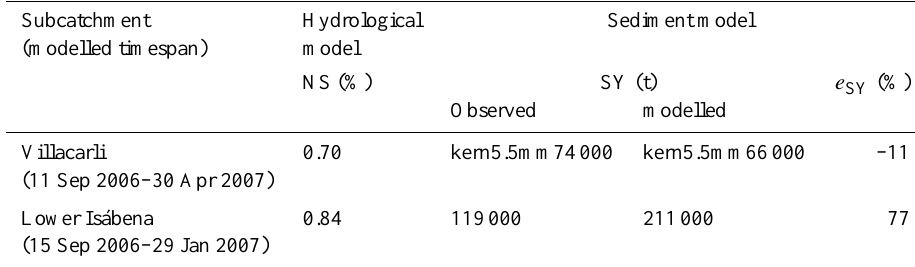
Table 6. Summary of model performance of the Is´abena.